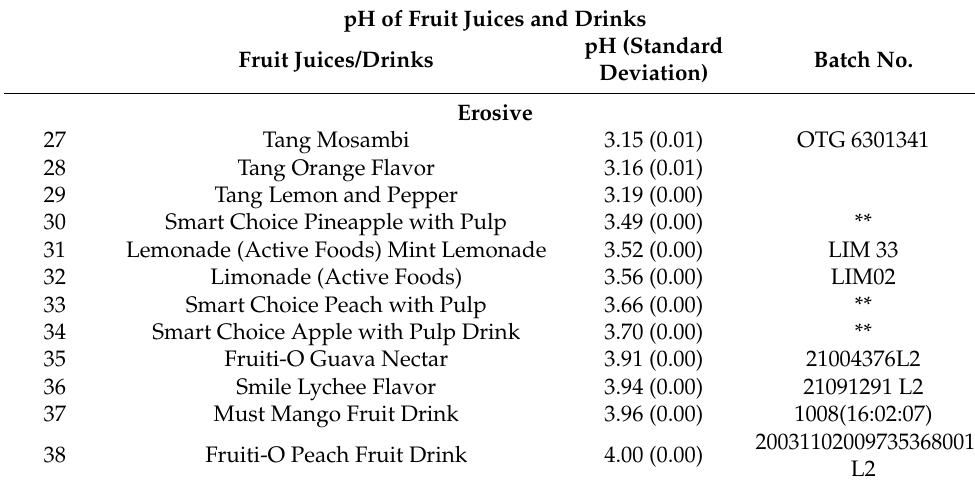
Table 3. pH (mean and standard deviation) of fruit juices and